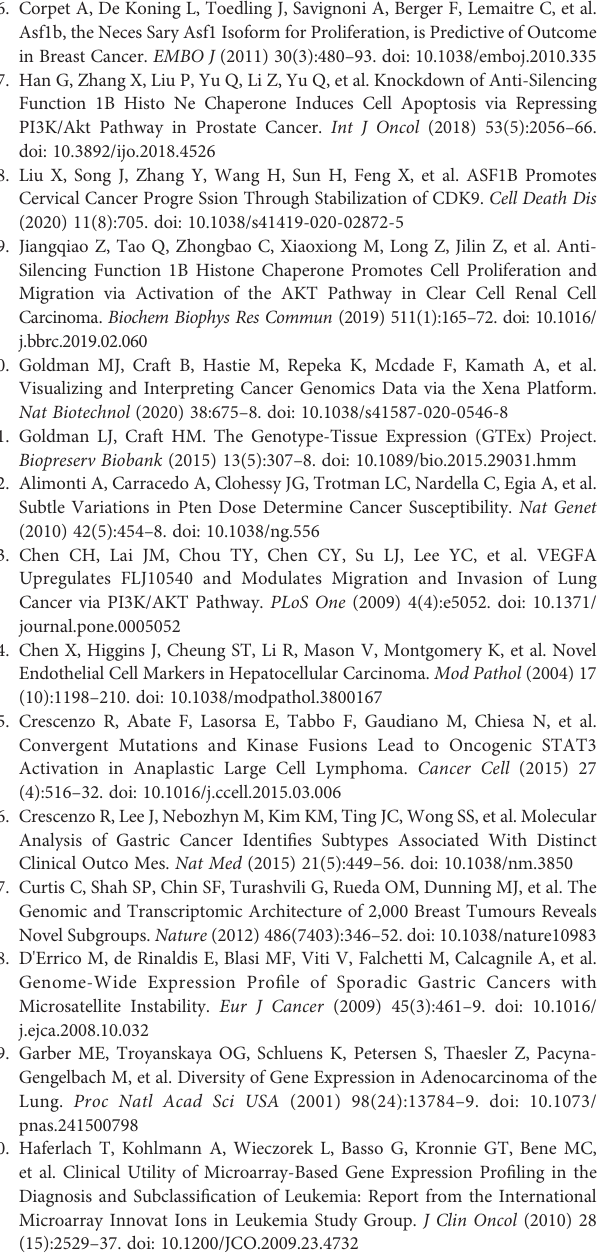
regulated proteins, blue represents down-regulated proteins, and black presents no signi fi cantly differentially expressed proteins. (Heatmap) The expression patterns of these differentially expressed proteins can distinguish between stable ASF1B-OE cell line and negative control. Supplementary Figure 10 | CKS1B correlated with prognosis and clinicopathology. Supplementary Figure 11 | Real-time PCR analysis of mRNA expression of ASF1B in H1975 Scramble cell lines compared to H1975 SH ASF1B cell lines. Supplementary Table 1 | The results of LC-MS from four group cell lines were intersected(Log